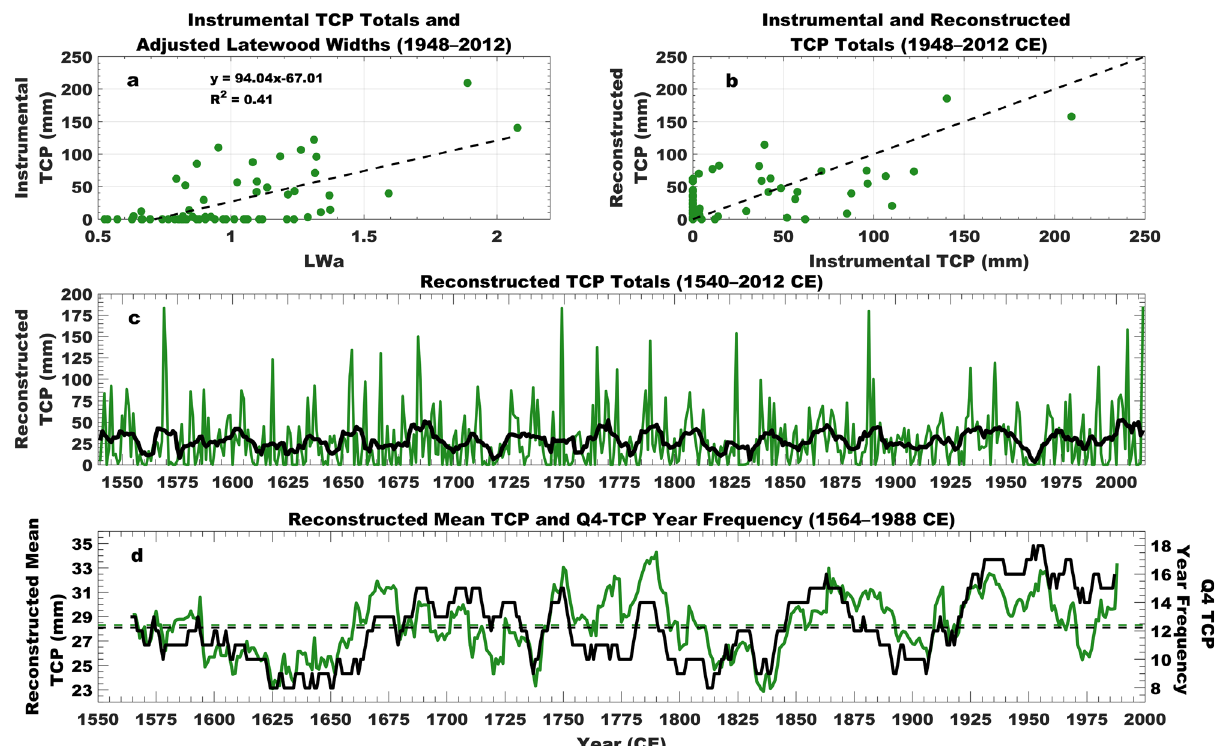
Fig. 2 Reconstruction of tropical cyclone precipitation. a Scatterplot between seasonal (July – September) instrumental TCP totals (mm) and adjusted latewood width (LWa) during the calibration period (1948 – 2012 CE). Black dashed line is the regression line. LWa and instrumental TCP exhibited a strong signi fi cant correlation with one another ( r = 0.64; p « 0.001). b Same as in a but using instrumental and reconstructed TCP totals instead. Black dashed line is the 1-to-1 line. c Annually -resolved reconstruction of seasonal TCP totals (green line) and a 10-year running average (black line) for the study period (1540 – 2012 CE). The peaks in the 10-year running average are an approximate marker of the fourth quartile cutoff ( ≥ 42.2 mm) used to calculate the frequency curve shown in d . d Reconstructed 50-year mean seasonal TCP totals (green line) and the frequency years with TCP totals ≥ 42.2 mm (fourth quartile, or Q4; black line) during the study period. A 50-year moving average and 50-year moving window were used to calculate mean TCP and Q4 frequency, respectively. Green and black dashed lines represent the averages of mean TCP (28.8 mm year − 1 ) and Q4 frequency (12.3 events 50-years − 1 ),